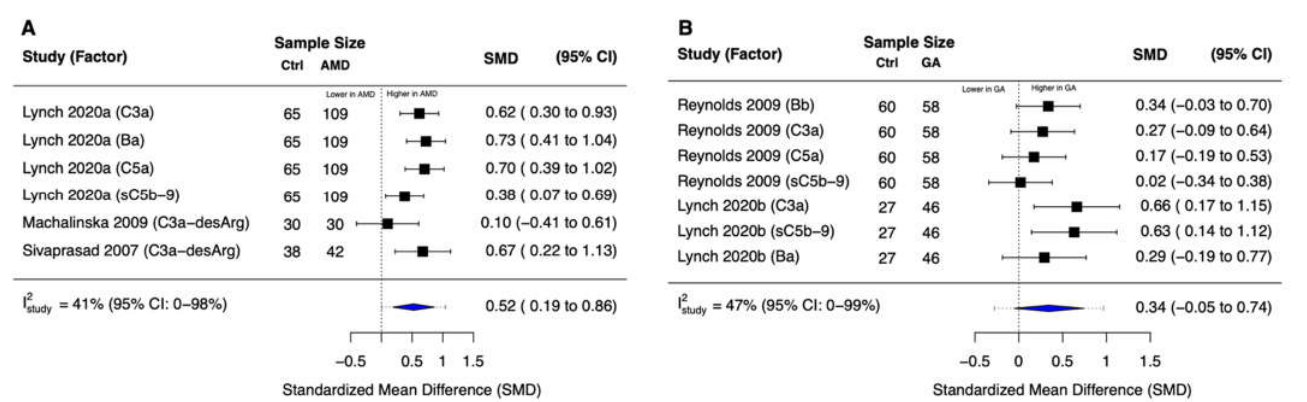
Figure 2. Forest plots for common final pathway activation products. ( A ) We observed significantly higher systemic levels of complement common final pathway activation products in patients with early to intermediate nonexudative AMD versus non-AMD controls ( p = 0.01). ( B ) There was no statistically significant difference in the systemic levels of complement common final pathway activation products in patients with geographic atrophy versus non-AMD controls ( p = 0.08). Blue diamonds denote the 95% confidence interval (CI); dashed tails denote the 95% prediction interval for this multi-level random-effects model.